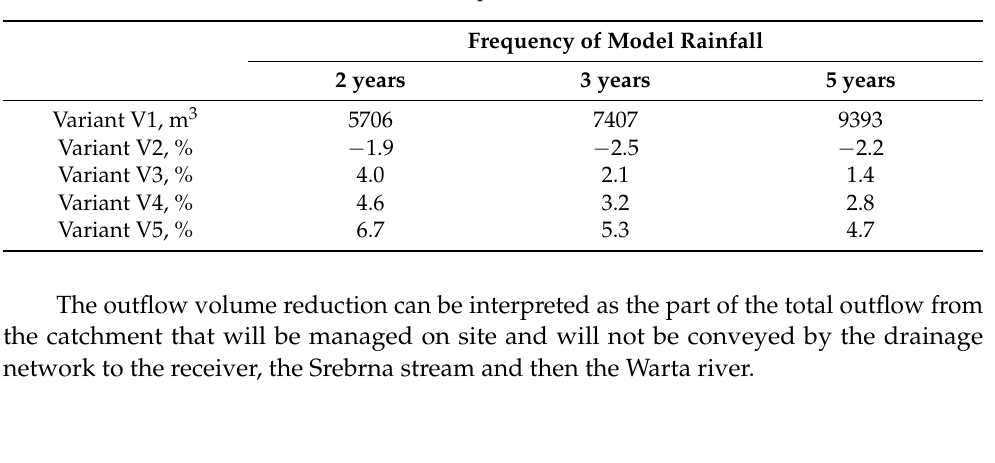
Table 9. Reduction of total outflow—summed up for the entire catchment